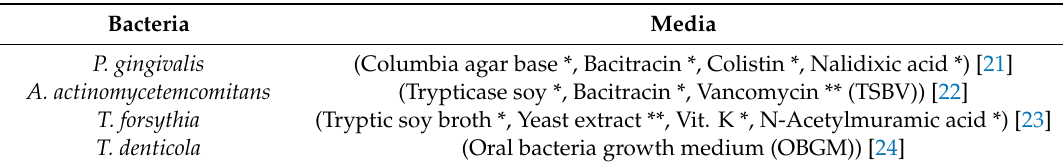
Table 1. Specific media used for bacterial